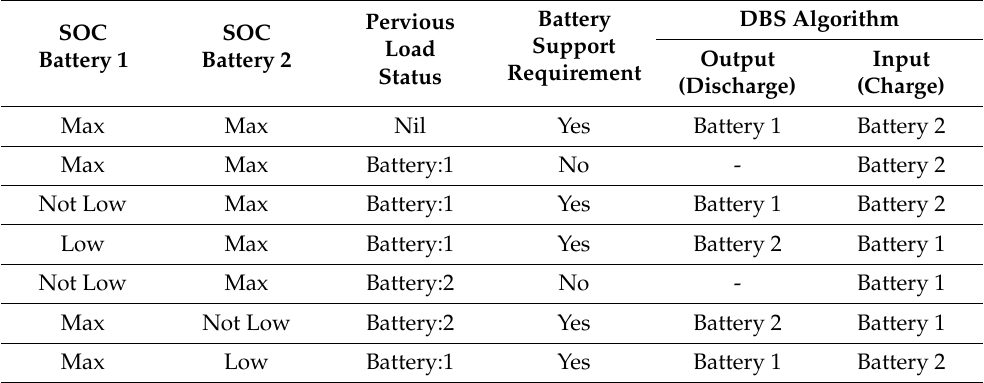
Figure 6. Circuit diagram of the dual battery mode 2 operation. Table 2. Functional concept of the dual battery algorithm.